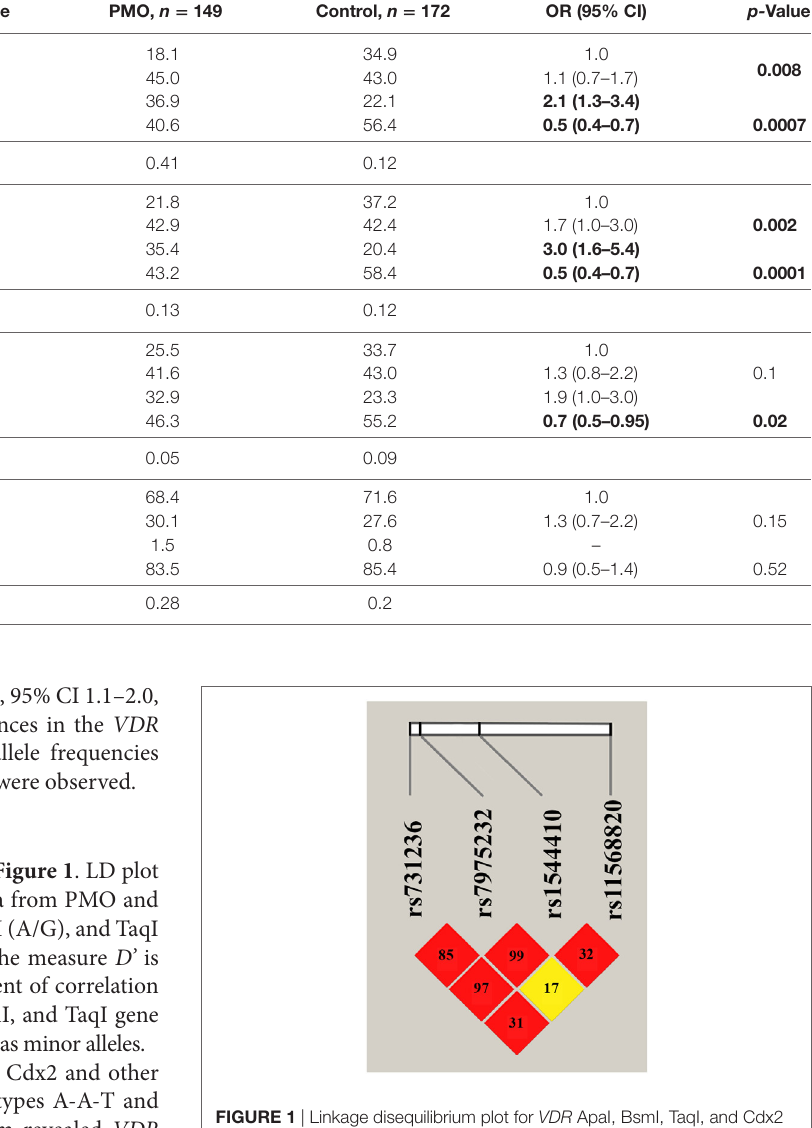
FiGURe 1 | Linkage disequilibrium plot for VDR ApaI, BsmI, TaqI, and Cdx2 variants. The LD plot was build using combined genotype data from postmenopausal osteoporosis and control groups (constructed with “haplo. stats” package for R). LD is displayed as pairwise D ’ values multiplied by 100 and given for each single nucleotide polymorphism combination within each cell. Red cells correspond to p < 0.0001, yellow— p > 0.1.